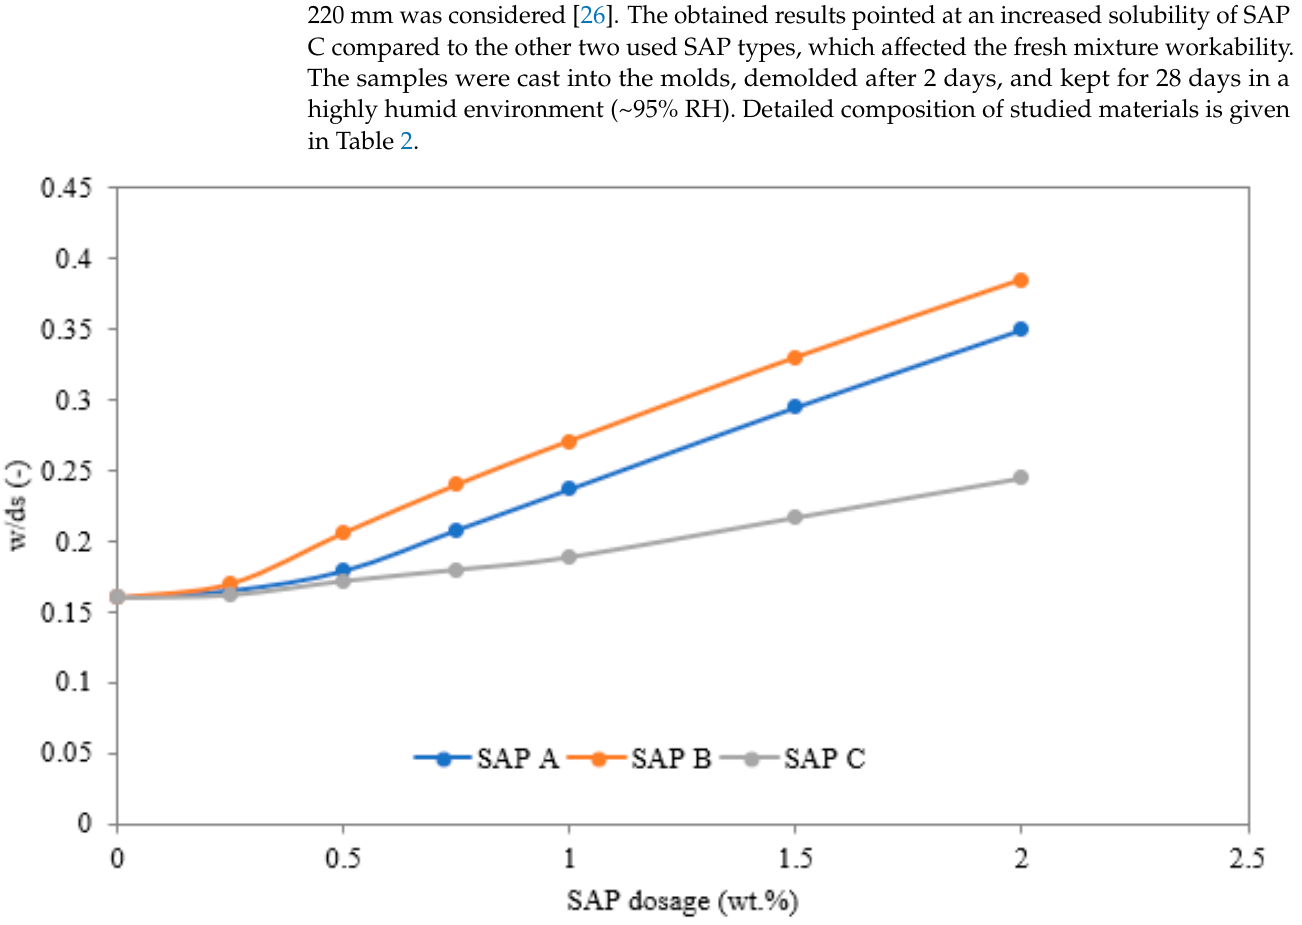
Figure 1. Relationship between SAP dosage and mass water/dry substance ratio for the spread di- ameter of 220 mm.